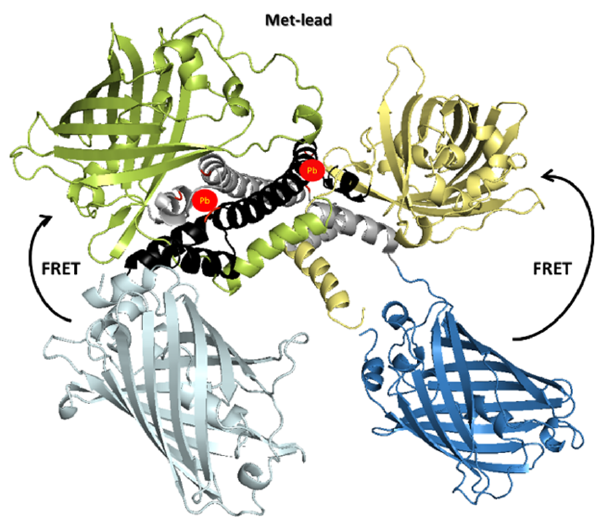
Figure 1. The predicted structure of Met-lead. Structural data from the MerR family member CueR [30] suggest that the lead sensing key (the PbrR protein, partial) is a dimer (shown in either gray or black for another strand in the homology modeling). Thus, the structure of Met-lead may also, in dimer form, bind two lead ions (red circles). The fluorescence resonance energy transfer (FRET) protein ECFP( ∆ C11) is displayed in either blue or light blue, and cpVenus is displayed in yellow or green. The two lead-binding pockets at the opposite edges of each PbrR-sensing domain near the two FRET pairs are composed of the three cystine residues shown in red. Inside Met-lead, FRET events may happen upon the occurrence of lead ions through the driving of these two pairs together to favor energy transfer